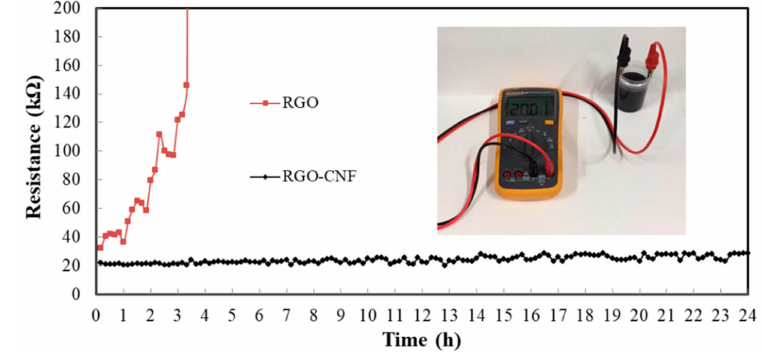
Figure 3. The changes in resistance of two suspensions over